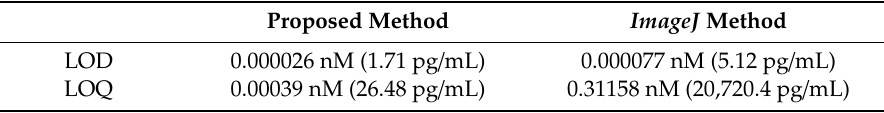
Table 7. Performance comparison between ImageJ software and our proposed method.